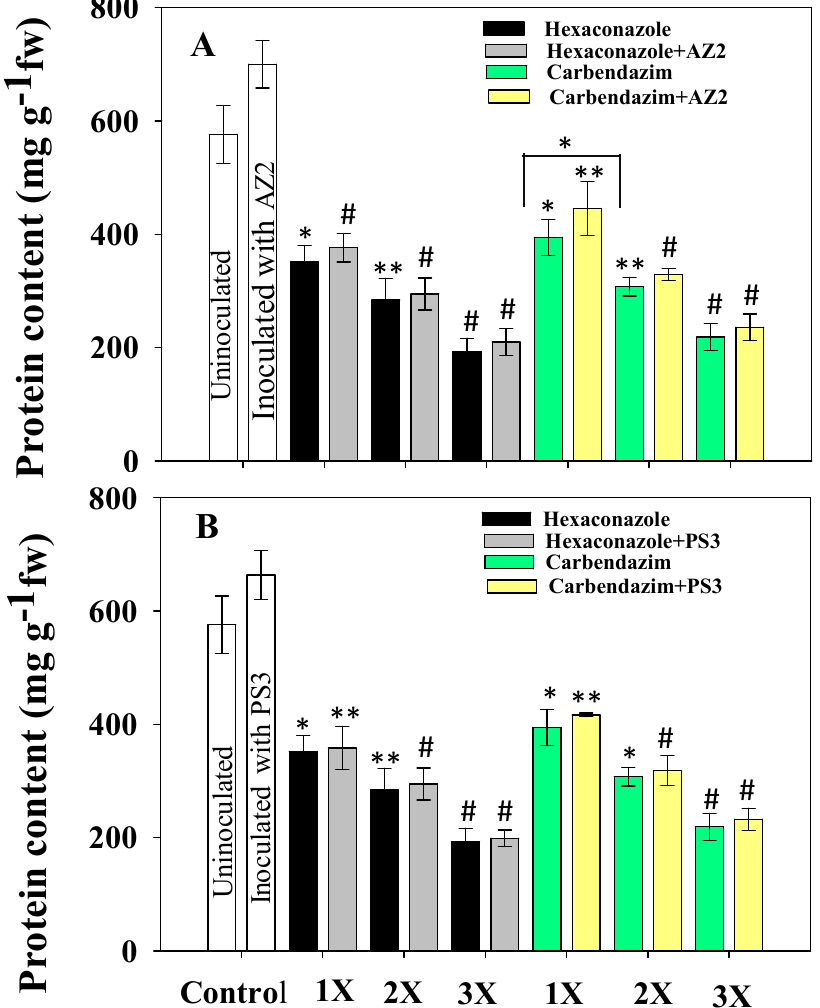
Figure 8. Protein content mg g − 1 fresh weight (fw) in fresh R. sativus grown with varying concentrations of fungicides carbendazim and hexaconazole, and inoculated with Pseudomonas sp. AZ2 ( A ) and Pseudomonas sp. PS3 ( B ). In this figure, histograms represent the mean value of three independent replicates ( n = 3) and error bars represent S.D. The asterisks *, ** and # denote statistical significance at p < 0.05, p < 0.005 and p < 0.001, respectively computed by Student’s t -test. 1X, 2X and 3X denote the normal, two times and three times greater concentrations of fungicide.